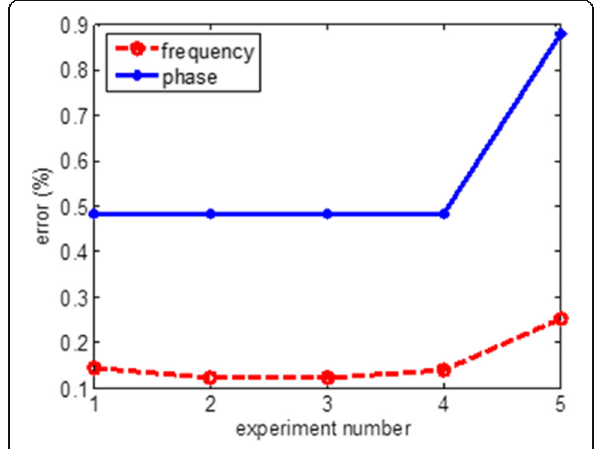
Fig. 11 The relative errors